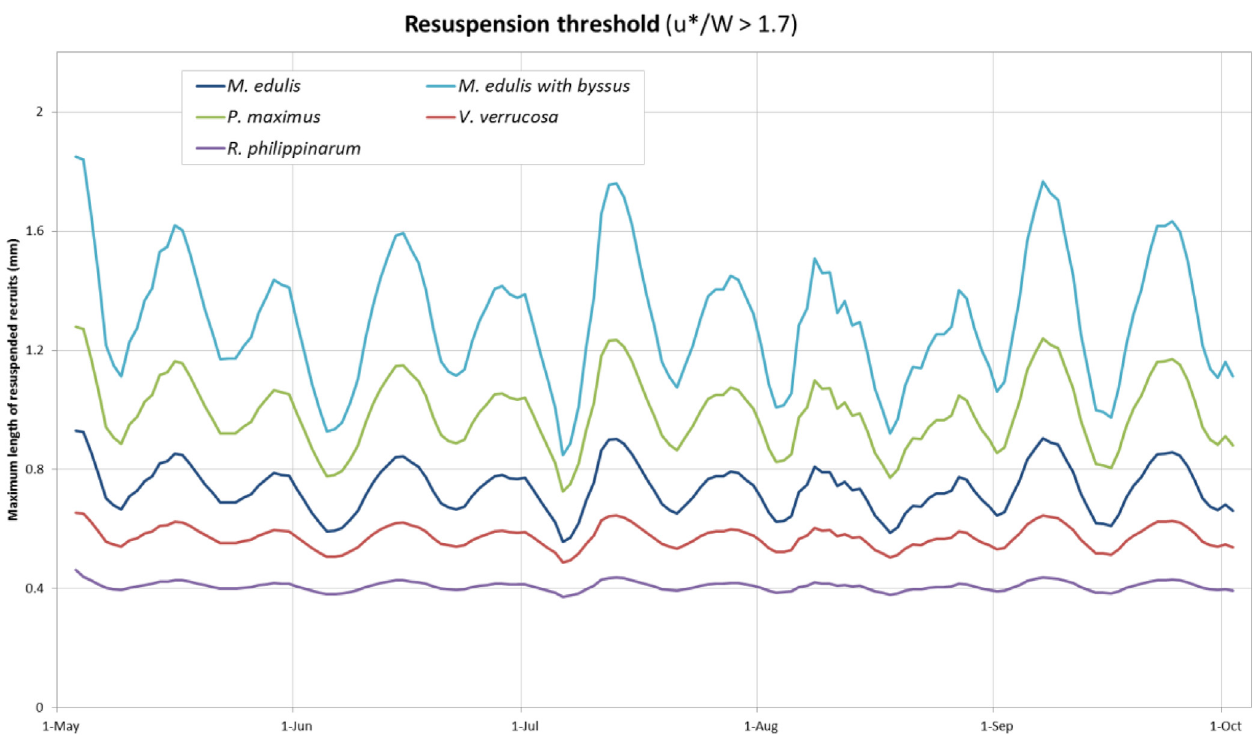
Fig. 3. Time-series of maximum length of potentially resuspended active recruits for the four species and M. edulis active recruits producing byssus thread during 5 months of the recruitment season 2014. Five-days moving average.